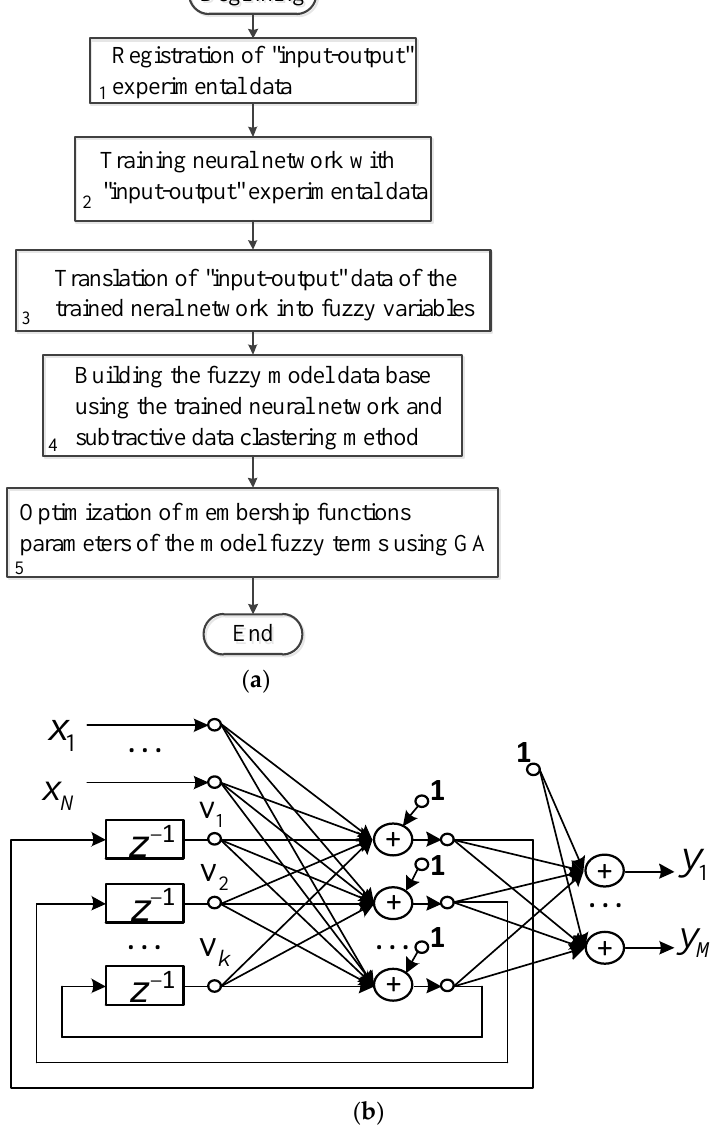
Figure 4. Block schematic diagram of the algorithm for building an optimized fuzzy model ( a ) and the structure of the Elman neural network ( b ).